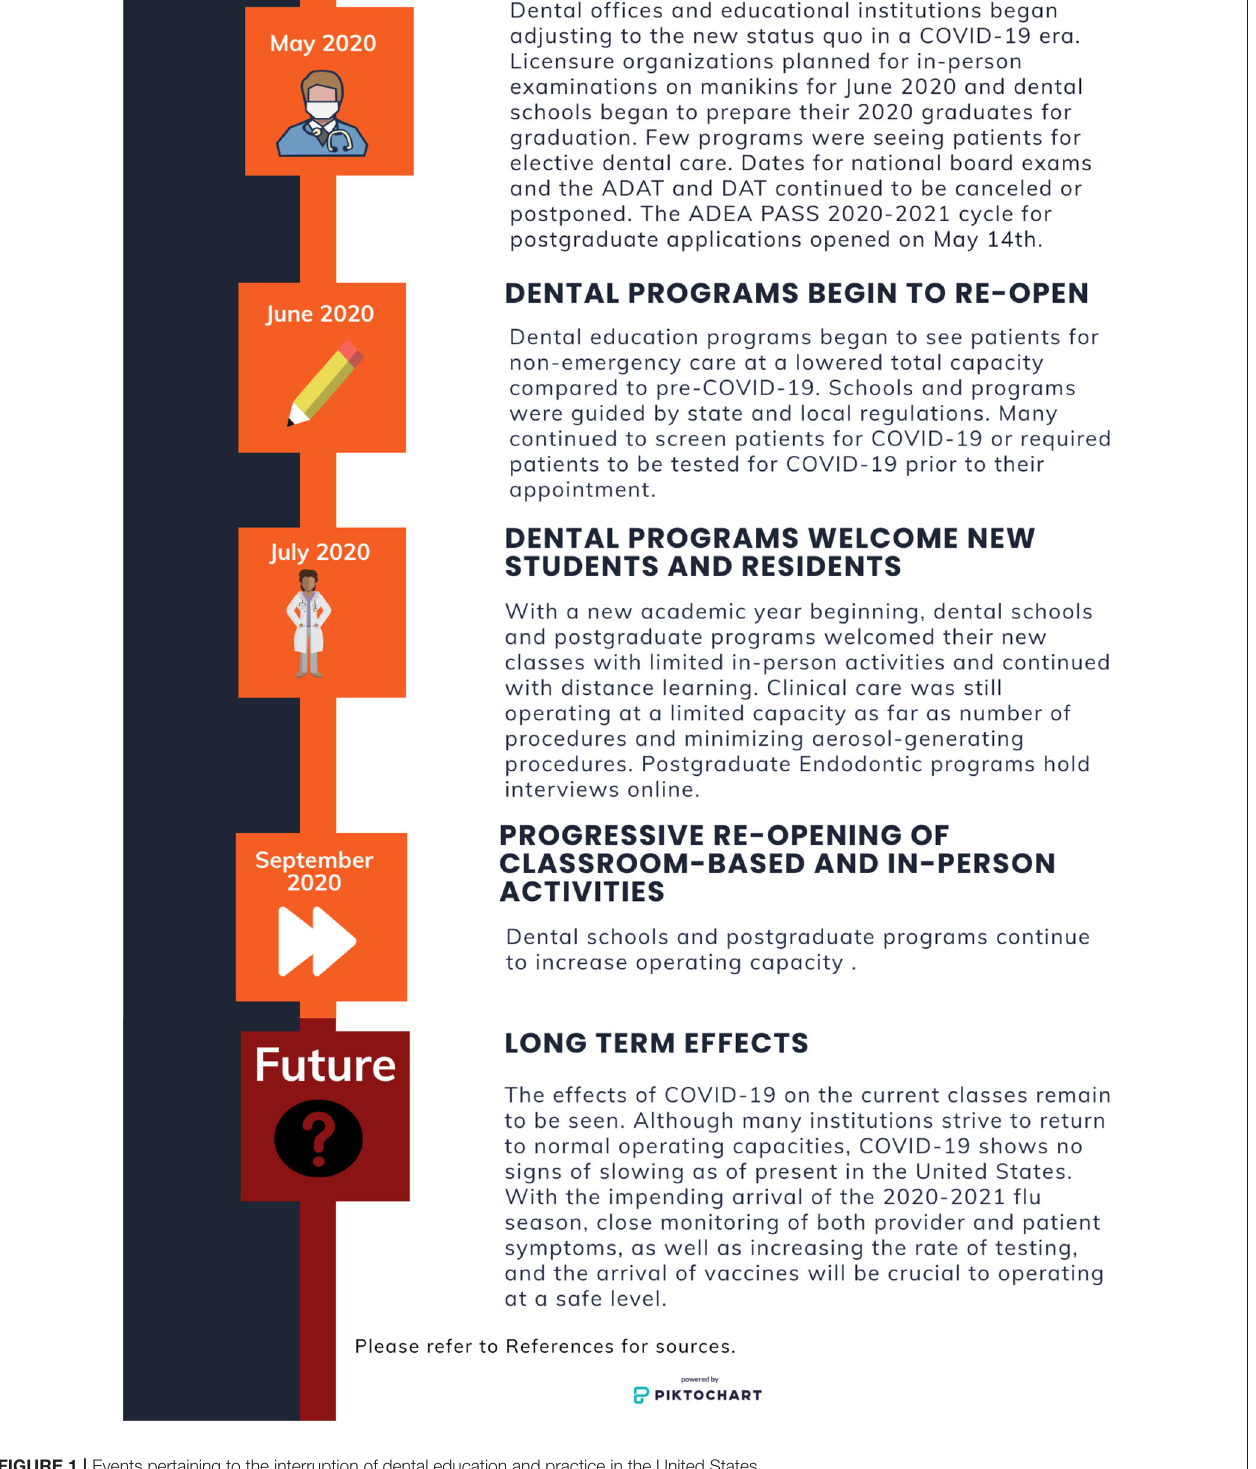
Frontiers in Dental Medicine |